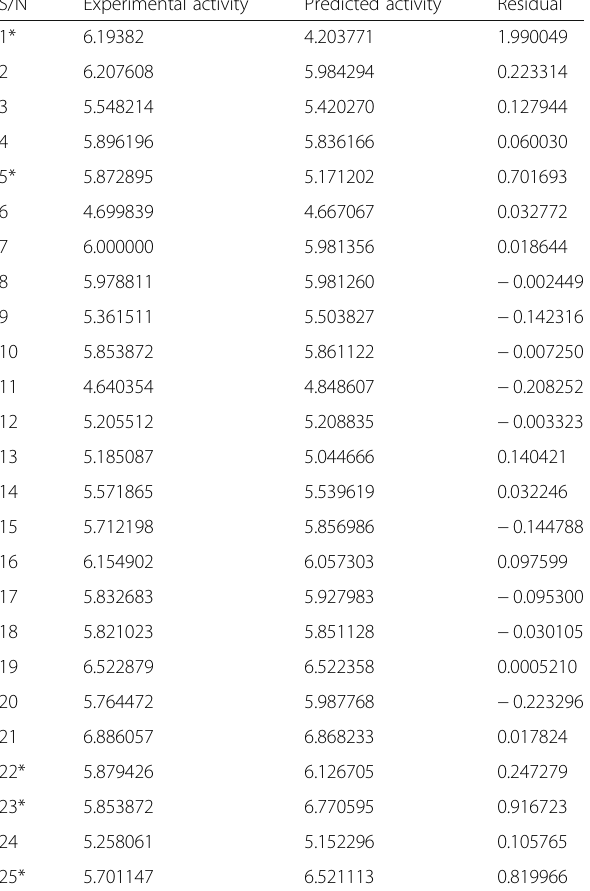
Table 6 Experimental, predicted and residual values of